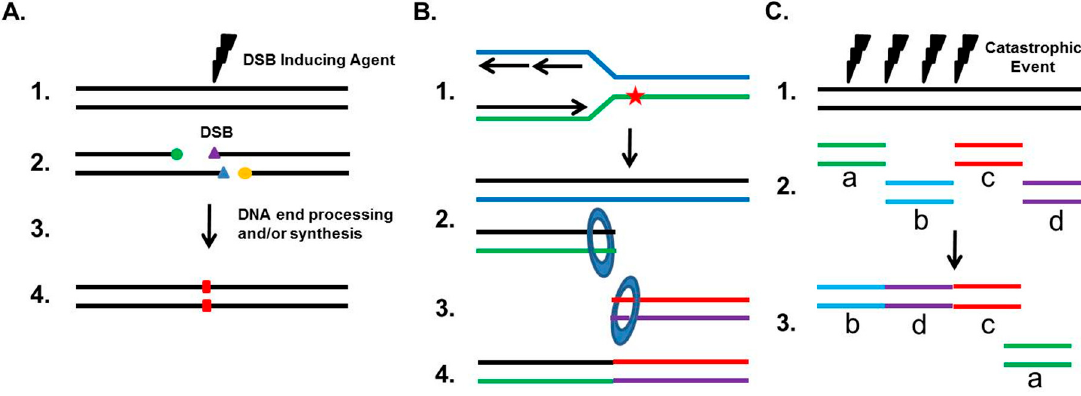
Figure 2. NHEJ-mediated chromosomal aberrations. ( A ). If the two junctions of the DSB (1.) are incompatible for ligation (2.), they will be processed (3.), which can result in small deletions, insertions via the fill-in polymerases, or indels (designated as a red rectangle) (4.); ( B ). Homologous recombination typically directs the repair of one-ended DSBs, which arise when a replication fork collapses or when the replication fork hits a DNA lesion (designated as a red star) (1.). However, if NHEJ attempts to repair one-ended DSBs (2.), it will do so by using a distal DSB to mediate repair (3.), resulting in a translocation (4.); ( C ). A single catastrophic event, termed chromothripsis (1.), can produce multiple DSBs of a chromosome (2.), which are then randomly rejoined by NHEJ in a chaotic genomic structure (3.).